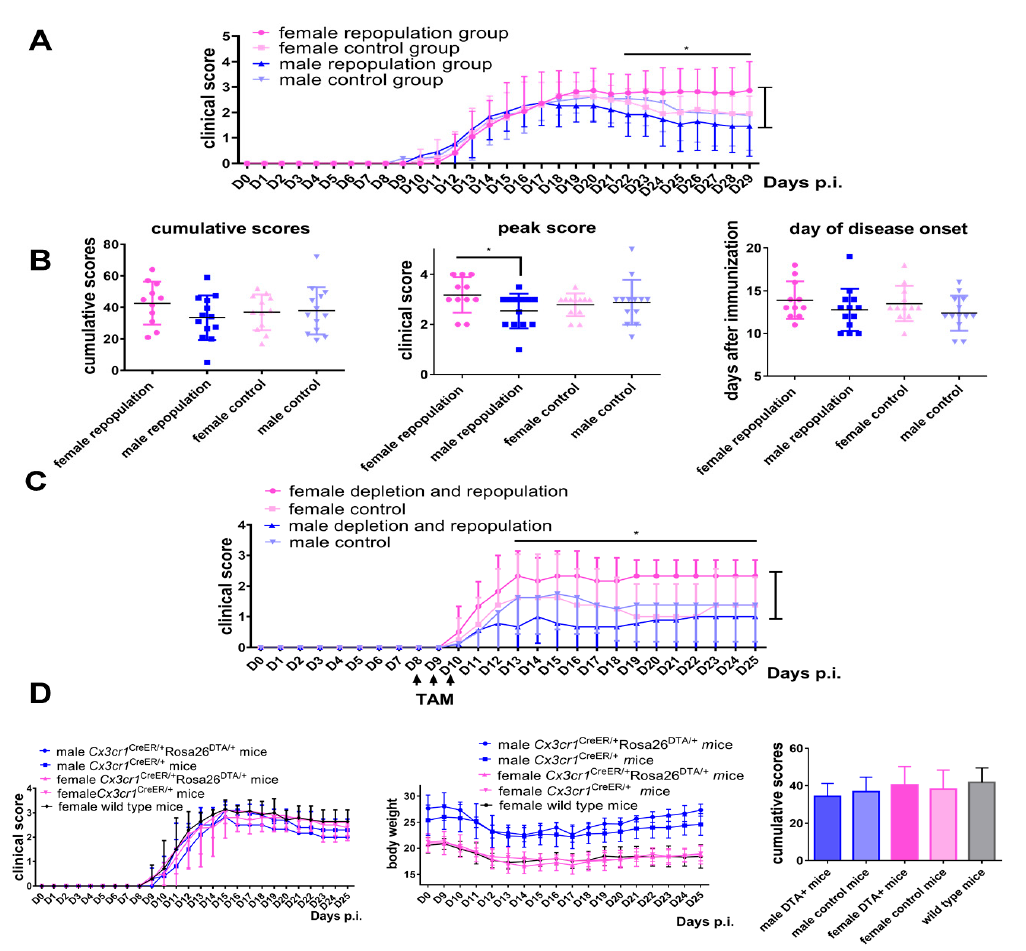
Figure 3. Female Cx3cr1 CreER /+ Rosa26 DTA /+ mice develop more severe experimental autoimmune encephalomyelitis (EAE) after engraftment of microglia-like cells ( A ) Tamoxifen was first administered and myelin oligodendrocyte glycoprotein (MOG)-EAE was subsequently induced when microglia were repopulated (one month later). Clinical scores of neurological deficits post-immunization up to 29 days are indicated. Female Cx3cr1 CreER /+ Rosa26 DTA /+ mice ( n = 11) with newly repopulated microglia (dark pink color) had a similar disease onset but experienced a higher disease severity during the chronic stage than did male Cx3cr1 CreER /+ Rosa26 DTA /+ mice ( n = 13) with newly repopulated microglia (dark blue color, * p < 0.05). Female Cx3cr1 CreER /+ mice ( n = 12) with resident microglia (light pink color) experienced similar clinical scores during the whole EAE period when compared with male Cx3cr1 CreER /+ mice ( n = 13) with resident microglia (light blue color). Data are representative of two independent experiments. ( B ) Peak disease score, day of disease onset and cumulative scores of both male and female groups are depicted during EAE. ( C ) EAE was first induced and tamoxifen was subsequently administered on days 8, 9 and 10 post-immunization. Clinical scores of neurological deficits post-immunization up to 25 days are presented ( n = 6, 8, 9, 8, respectively). ( D ) Di ff erent mouse strains ( Cx3cr1 CreER /+ Rosa26 DTA /+ male and female mice, Cx3cr1 CreER /+ male and female mice and C57BL / 6 female wild-type mice, n = 3, 9, 5, 5, 7, respectively) without tamoxifen injections developed similar clinical scores and cumulative EAE scores. Statistical significance is indicated as * p <